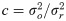
Replication probability.Probability of a significant replication outcome in the same direction as in the original study at (two-sided) α = 0.05 level as a function of the test statistic to (bottom axis) and p-value po (top axis) of the original study and variance ratio c=σo2/σr2. The dashed line indicates z0.025 ≈ 1.96. In the case of heterogeneity, d=τ2/σo2 is set to one, otherwise to zero.